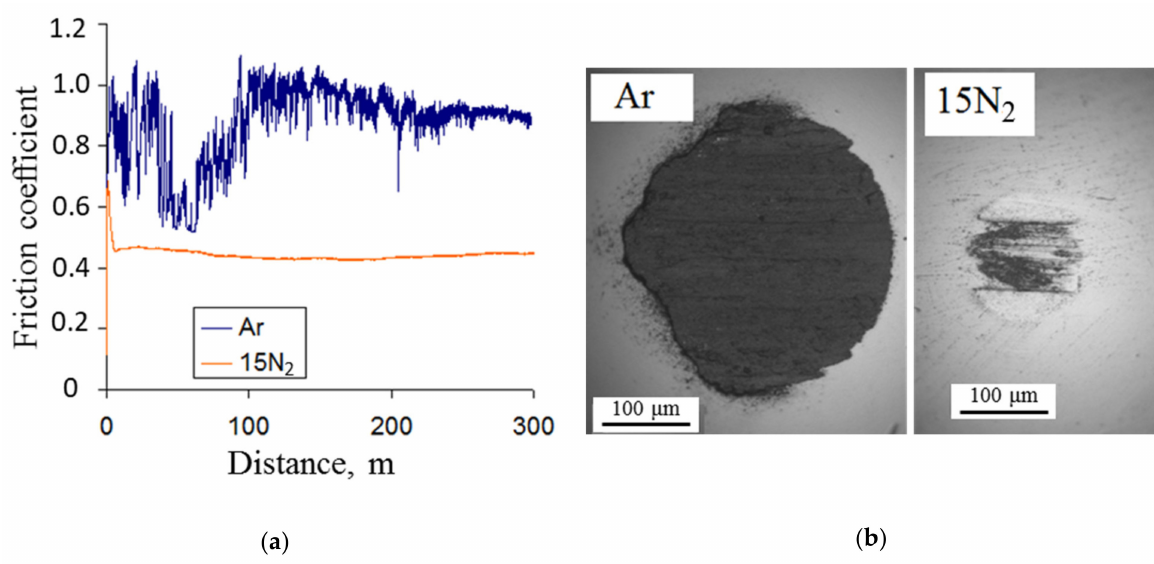
Figure 6. Dependence of the friction coefficient on the distance ( a ) and photo of the wear zones of the counter-bodies ( b